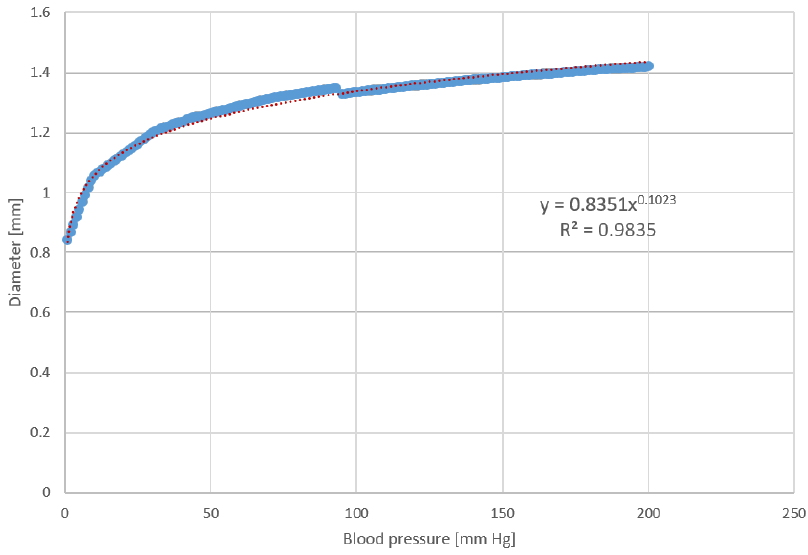
Figure 4. Pressure–diameter relation of the artery. Figure 4. Pressure – diameter relation of the artery. Absorption coefficients of the whole blood and artery vessel wall at wavelengths of 905 nm and 940 nm are adopted from [26,27] and listed in Table 5. Table 5. Absorption coefficients of whole blood and vessel